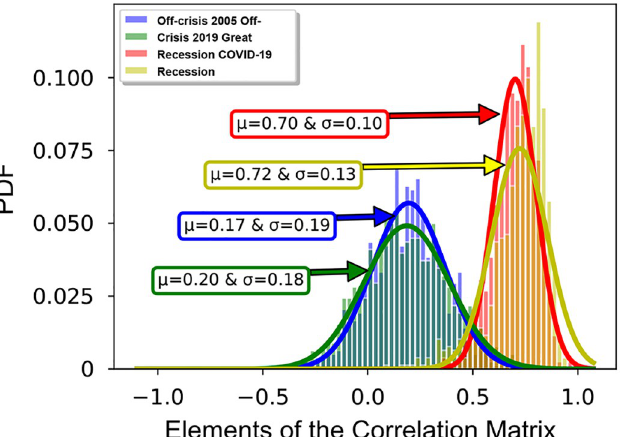
Fig 2. Probability distribution in on and off crisis periods. The probability distribution function (PDF) of correlation matrix for four periods of time. Fitted curves to off-crisis 2005(blue), off-crisis 2019(green) both have small mean values in regards to on-crisis periods which is a representation of weak correlation of stocks in off-crises periods. The positive mean values of curves in the on-crises periods, Great Recession 2008(red), Covid-19 Recession 2019 (yellow), demonstrate the strong correlation between